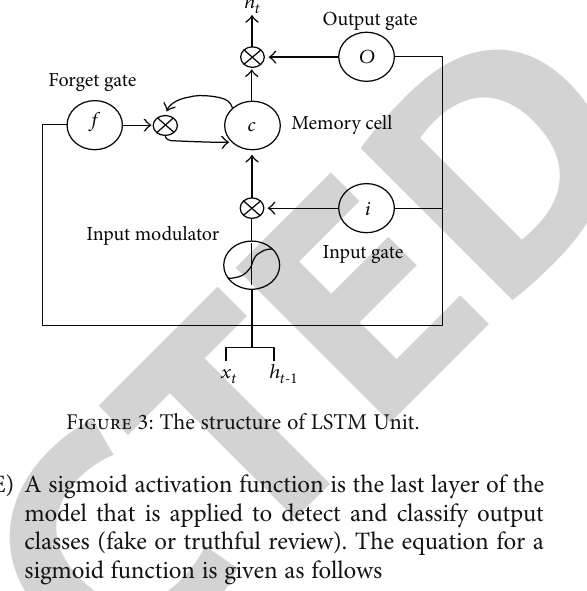
Figure 3: The structure of LSTM